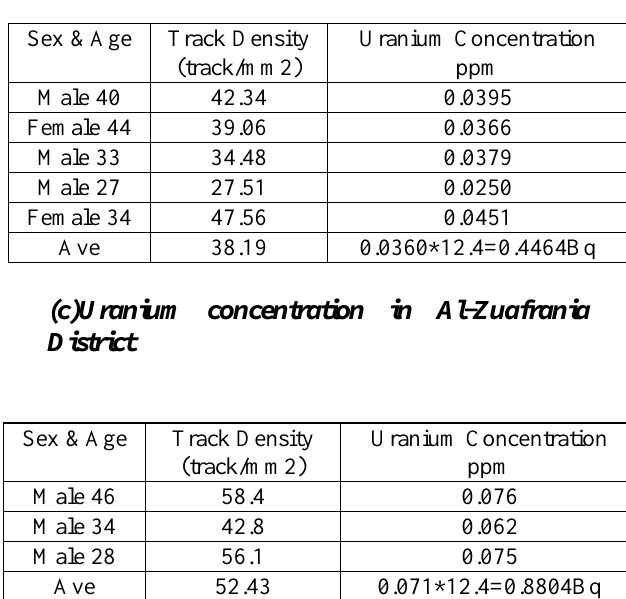
Fig.2: The relation between track density and uranium concentration.